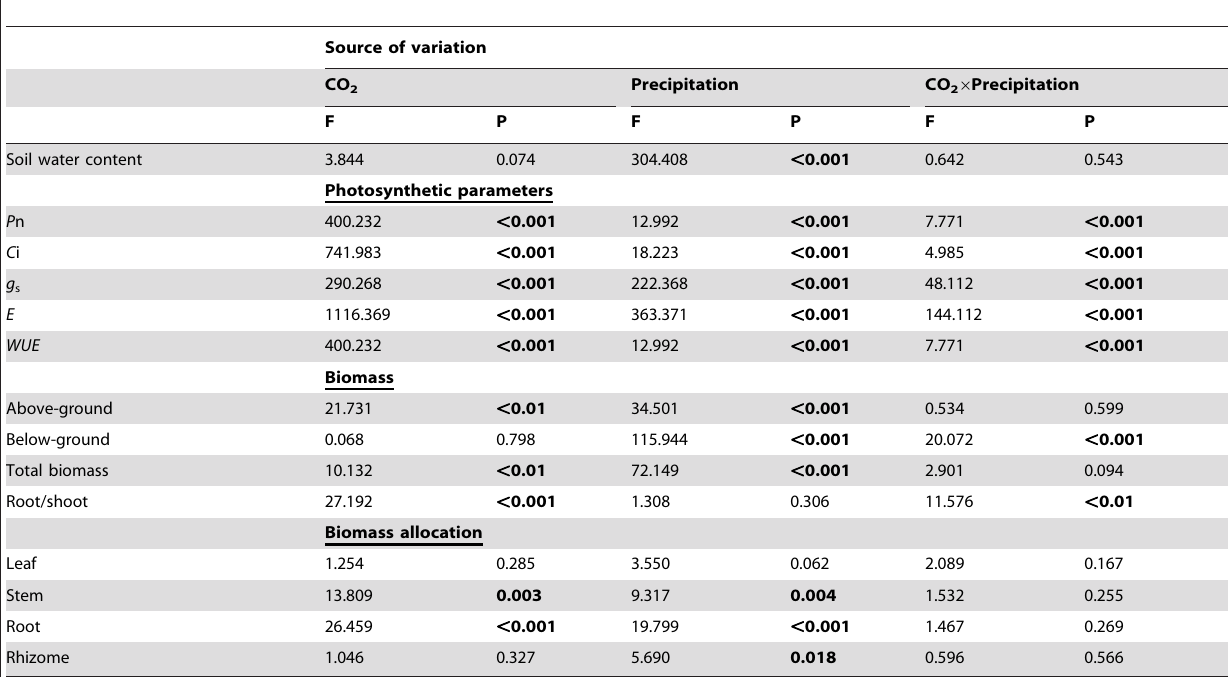
Table 1. Analysis of variance to assess the impacts of precipitation, CO 2 , and their interaction on soil water content, photosynthetic parameters, biomass accumulation and biomass allocation in the grass species L. Chinensis